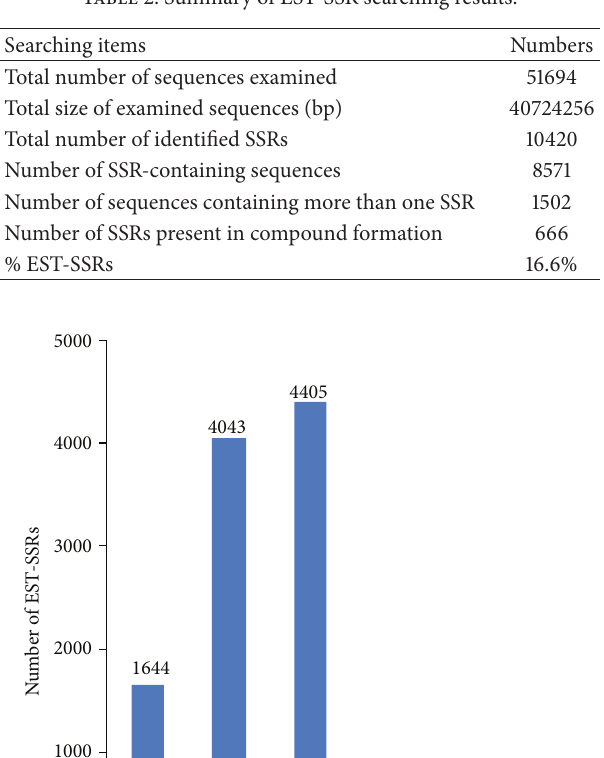
Table 2: Summary of EST-SSR searching results.